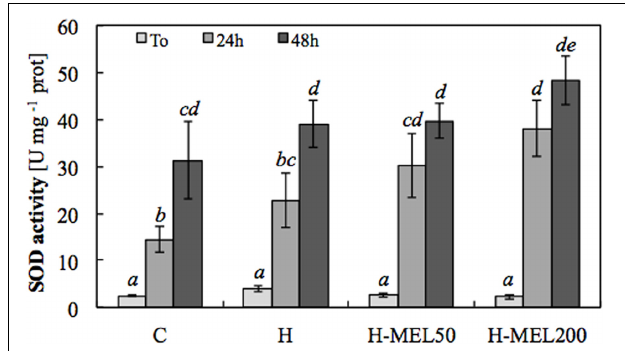
FIGURE 5 | Superoxide dismutase (SOD) activity in leaf disks cut from 24-day-old pea plants grown from the control (C), hydroprimed (H), and hydroprimed with an aqueous solution of 50 µ M melatonin (H-MEL50) or 200 µ M melatonin (H-MEL200) seeds. Measurements were performed at T 0 (before PQ treatment) and after 24 and 48 h of disk incubation in 75 µ M PQ solution. The results are expressed as mean values of about 6–9 measurements ± SEM. Two-way ANOVA and Duncan’s post hoc test were performed. The small letters on the graphs show statistical significance. ANOVA results: SOD – Variant (C, H, H-MEL50, and H-MEL200) F ( 3 , 75 ) = 5.51 p < 0.001; Time ( T 0 , 24 and 48 h) F ( 2 , 75 ) = 90.7 p < 0.0001; and interaction Variant × Time F ( 6 , 75 ) = 2.12 p <